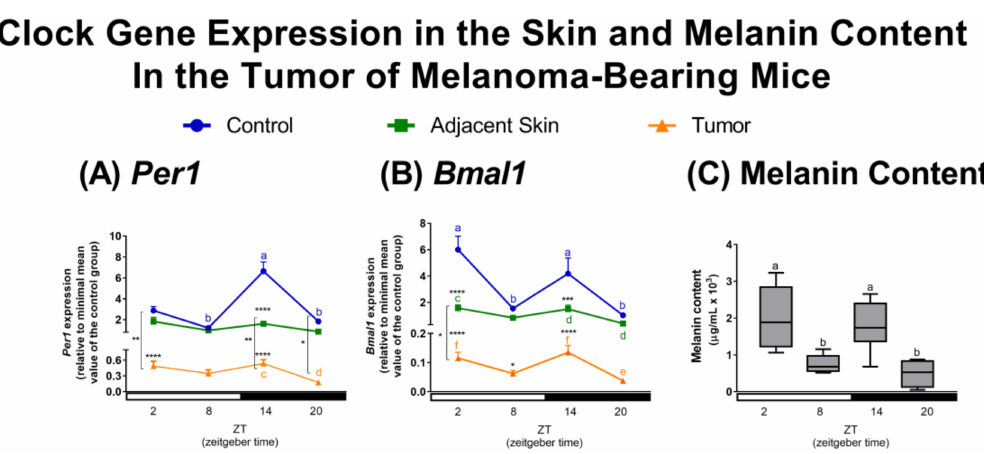
Figure 1. ( A , B ) Non-metastatic skin melanoma affects clock gene expression in skin. Expression of ( A ) Per1 , ( B ) Bmal1 in control skin, tumor-adjacent skin, and tumor samples. Letters represent significant differences in gene expression within the same group, Two-Way ANOVA followed by Tukey post-test. In ( A ) a (cid:54) = b , p < 0.01, and c (cid:54) = d , p < 0.05. In ( B ) a (cid:54) = b , p < 0.01, c (cid:54) = d , p < 0.01, and e (cid:54) = f , p < 0.05. Significant differences among groups were demonstrated by Two-Way ANOVA followed by Bonferroni post-test, and are represented by asterisks having the control skin as reference. Differences between tumor-adjacent skin and tumor samples are indicated by brackets. * p < 0.05, ** p < 0.01, *** p < 0.001, **** p < 0.0001. Values are presented as the mean expression ( n = 3–7) ± SEM of the gene of interest normalized by Rpl37a RNA, relative to the minimal value of skin control group. ( C ) Temporal tumor melanin content. Boxplots show the median, quartiles, maximum, and minimum melanin contents. Melanin content was normalized by total protein. Letters represent statistical temporal differences in melanin content as revealed by One-Way ANOVA followed by Tukey post-test. a (cid:54) = b , p <